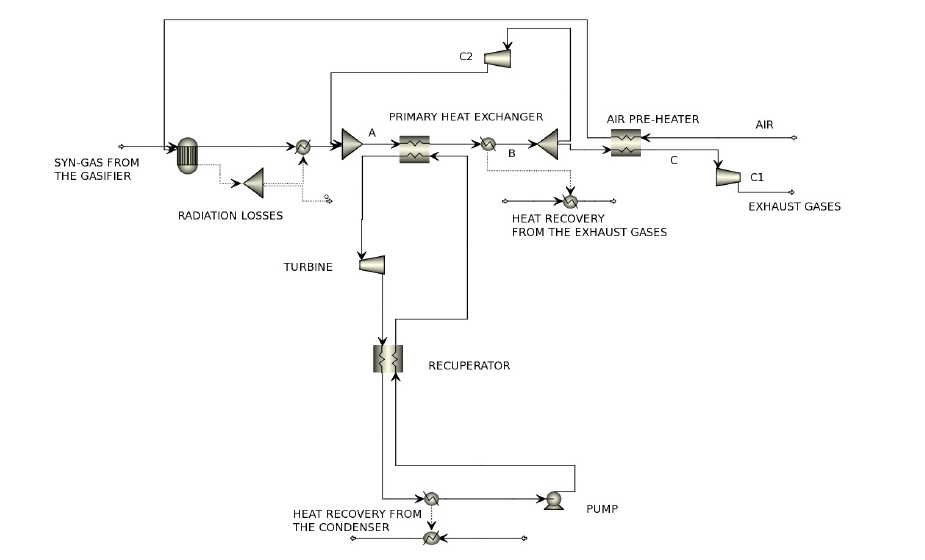
Figure 3. Plant scheme for the considered high temperature source. A single cycle ORC